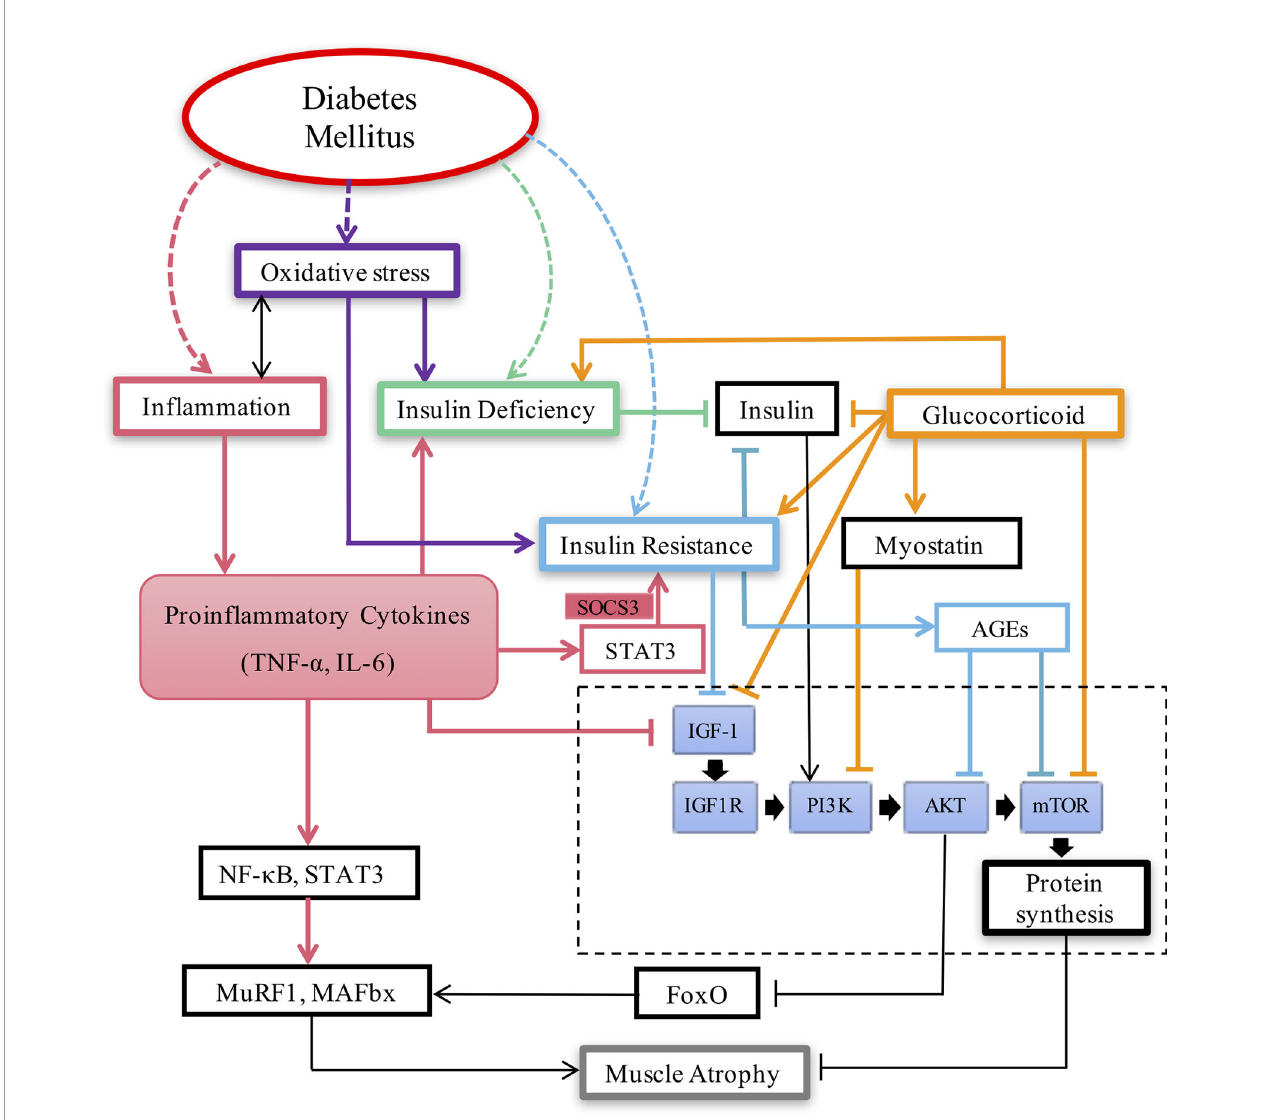
FIGURE 1 | Key pathways involved in Diabetic muscular